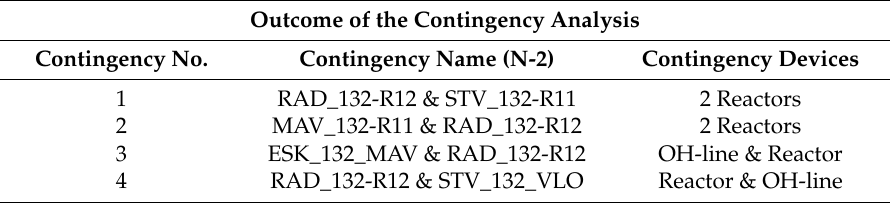
Table 4. The contingencies which are creating over voltages in the southern